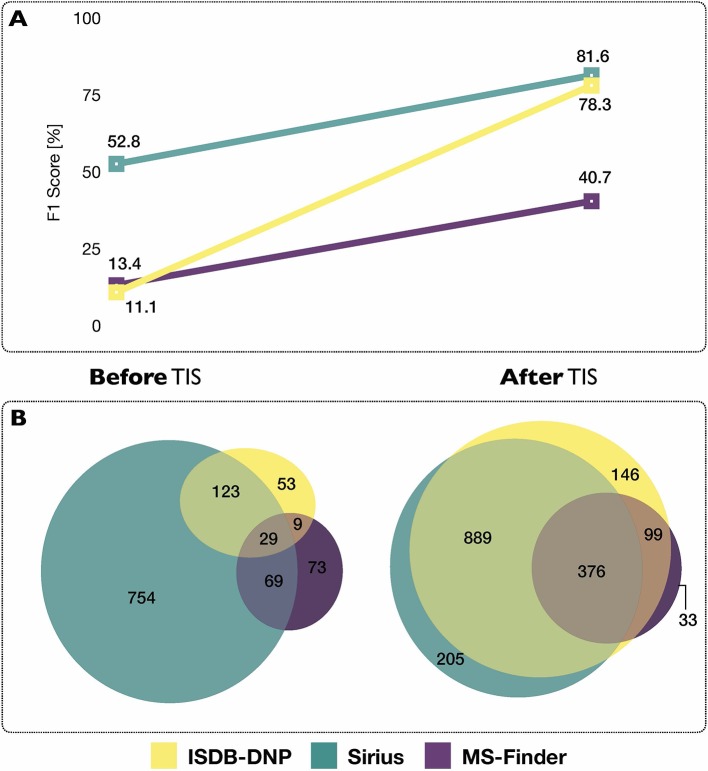

(A) Influence of the taxonomically informed scoring (TIS) on the F1 score of each metabolite annotation tool. The F1 score offers a global evaluation of the precision and recall rate of the annotation process, the higher the better. (B) Venn diagrams representing common and unique correct annotations of each tool at rank 1 before and after the taxonomically informed scoring step.